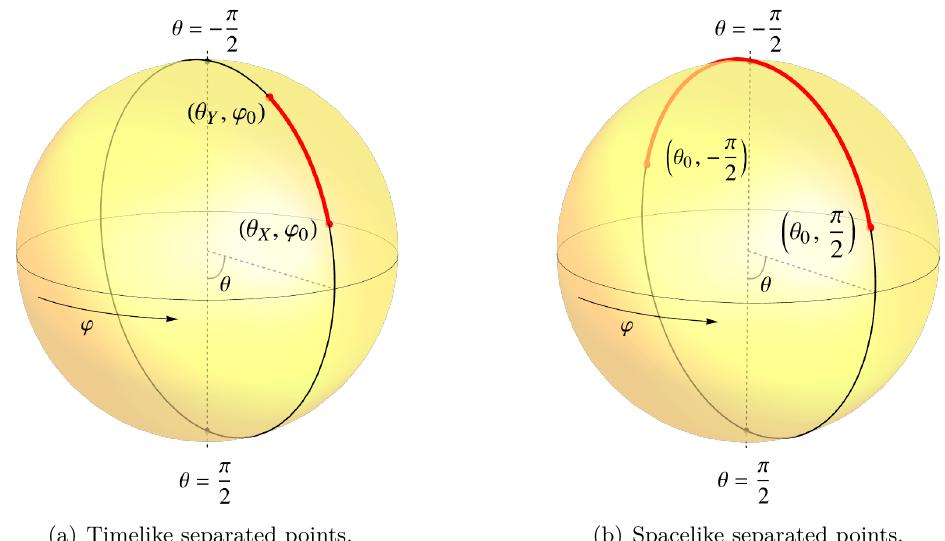
Figure 2 . Upon analytic continuation to the Euclidean sphere, we look for two different types of geodesics, depending on the type of correlator under consideration. The geodesic with shorter length is shown in red, while the one going on the other side of the great circle is shown in